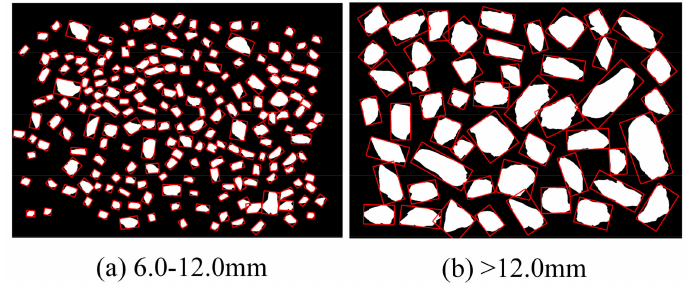
Figure 5. Minimum enclosing rectangles of coal fragments with different particle sizes: ( a ) 6.0–12.0 mm, and ( b ) >12.0